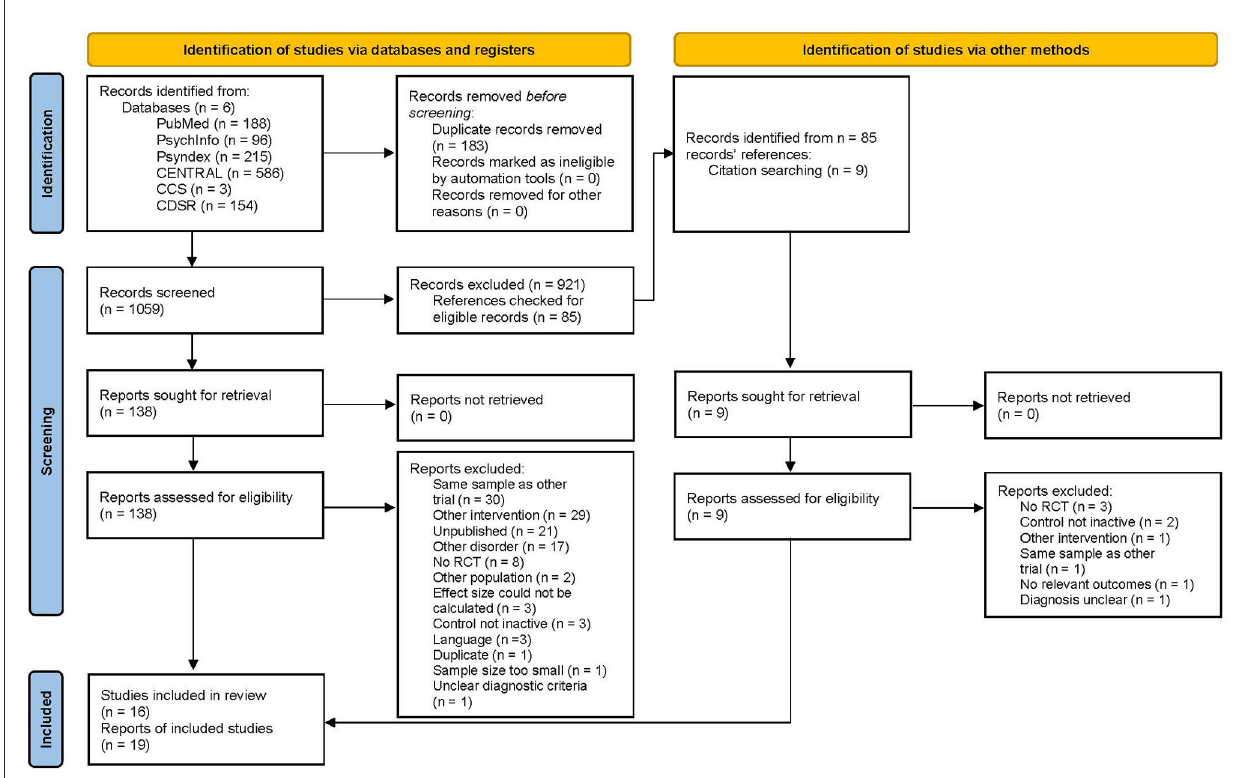
FIGURE1 PRISMA 2020 flow diagram [adapted from Page et al. (14)].